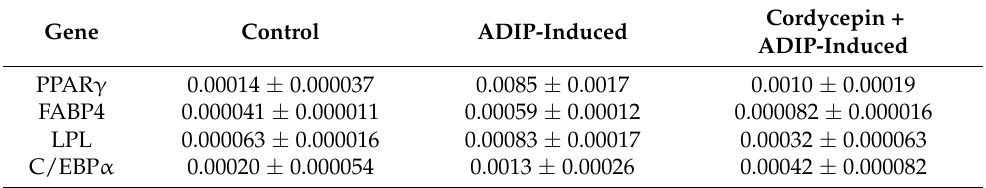
Table 4. Relative expression of adipogenesis related genes in the DPSC following treatment with cordycepin.